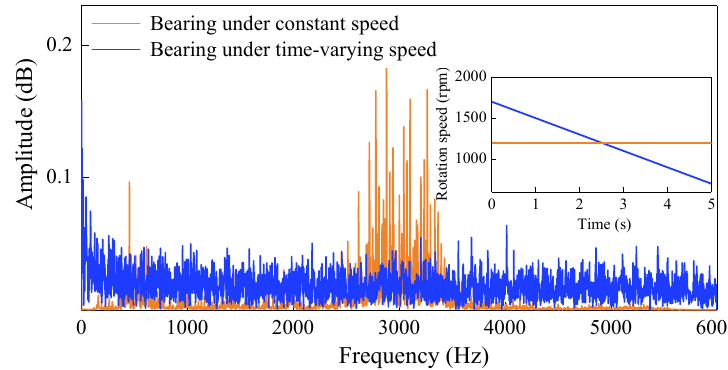
Figure 1. Spectrum blurring phenomenon at time-varying